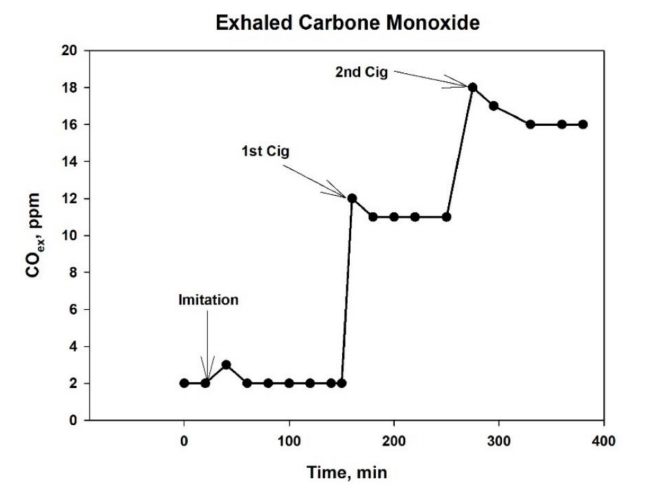
Figure 1. CO dynamics in the exhalation of a volunteer after smoking two nicotine-free cigarettes with an interval of 90 min.